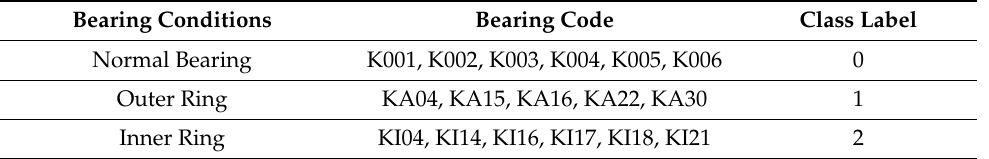
Table 3. Bearing conditions, bearing codes, and class labels for fault